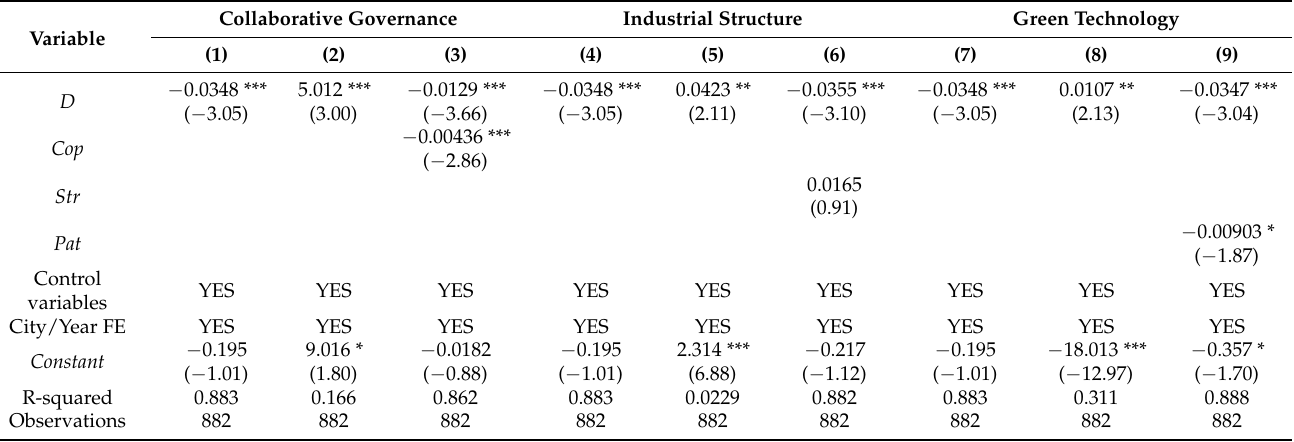
Table 8. Regression results of the mediating effect